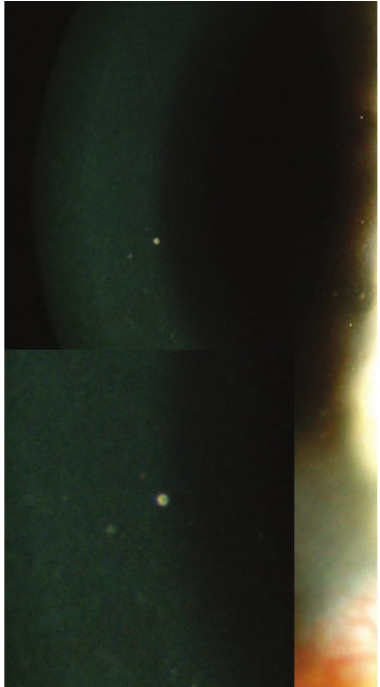
Figure 1. Sparse micro-granulomatous KPs, seen in magnification (insert) at presentation under the treatment of 1% prednisolone drops BID.